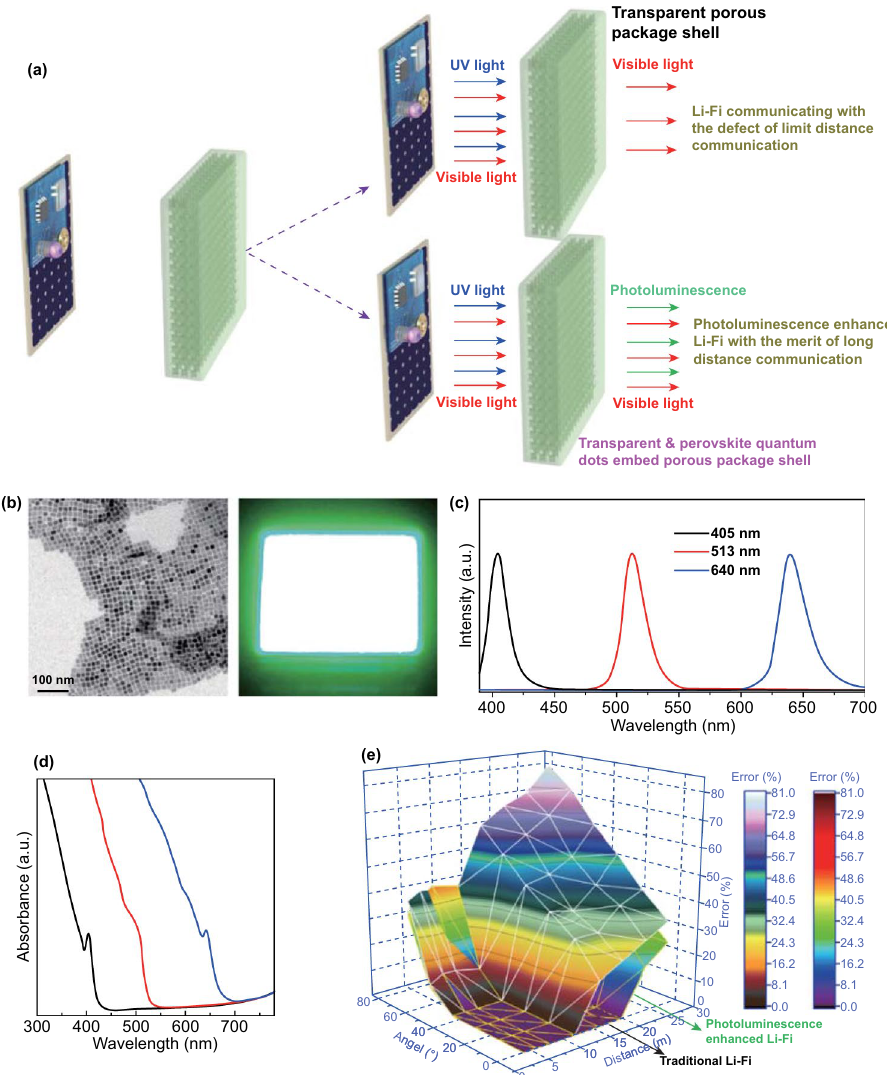
Fig. 3 Characterization of the photoluminescence-enhanced Li-Fi telecommunication: a Illustration of the photoluminescence-enhanced Li-Fi telecommunicating technique; b TEM image of the CsPbCl3 QDs and its photoluminescence under the 365 nm illumination; c PL emission spectra of colloidal perovskite QDs; d absorption spectra of colloidal CsPbCl 3 , CsPbBr 3 , and CsPbI 3 QDs; e Error analysis for the camera cap- tured signal, at the viewing angle of 0-80° and the viewing distance of 0-30 m. The photoluminescence-enhanced Li-Fi essentially extended the communication distance and maintained the accuracy of the transmitted data within the viewing angle of 45° and viewing distance of 20